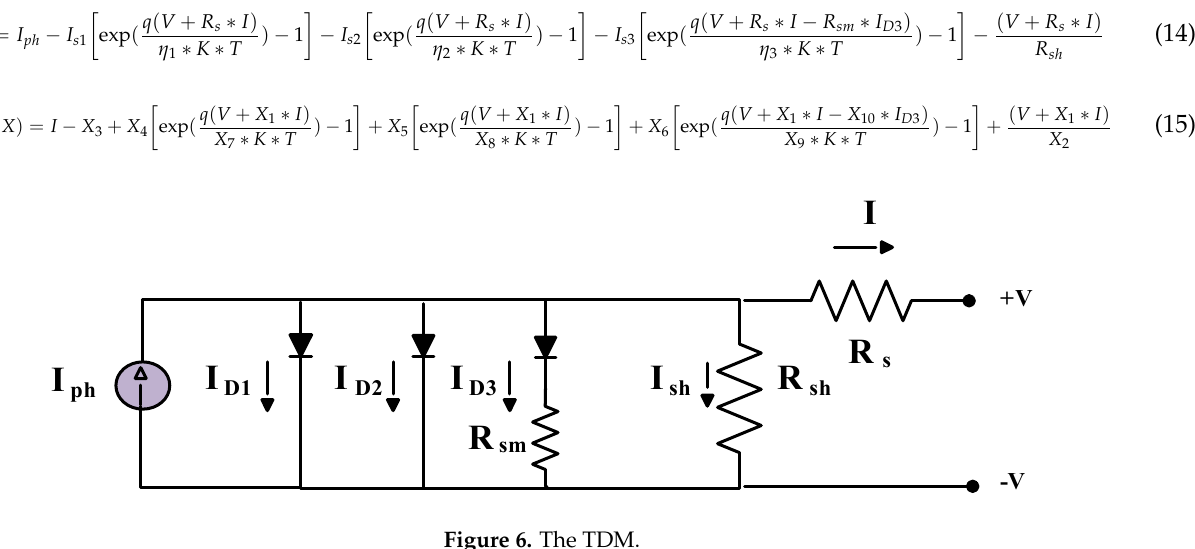
Figure 6. The Figure 6. The TDM.